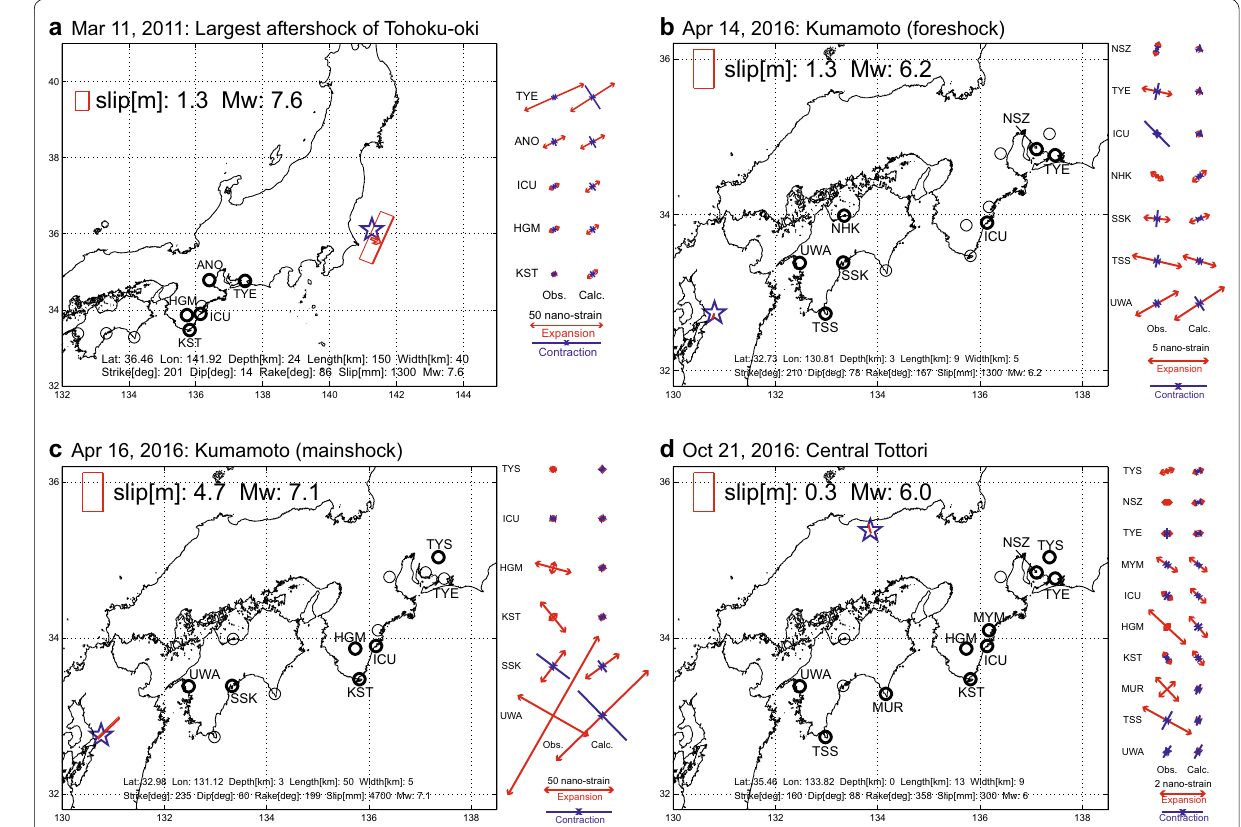
Fig. 5 Fault models (red rectangles) of four earthquakes estimated from borehole strain data, including observed and calculated principal strain changes at each station. a Largest aftershock of the M w 9.0 2011 Tohoku-Oki earthquake. b Foreshock of the M w 6.0 2016 Kumamoto earthquake. c Mainshock of the